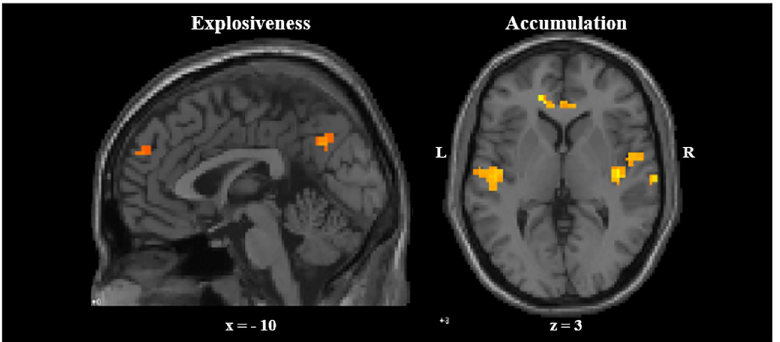
Fig 4. Neural correlates of emotion explosiveness and accumulation. Left panel: mPFC activation associated with emotion explosiveness. Right panel: Insula activation associated with emotion accumulation. Coordinates in the Talairach